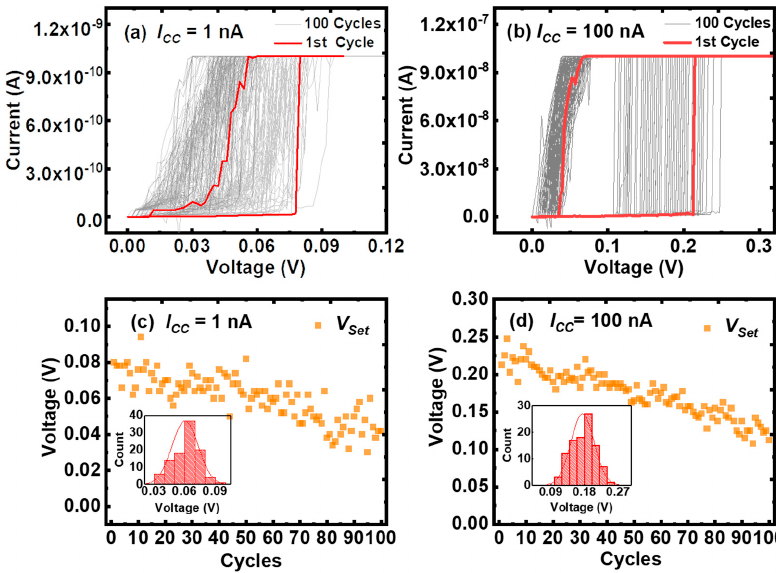
Figure 2. Typical threshold switching (TS) I-V curves under the compliance current limits of ( a ) 1 and ( b ) 100 nA. The statistics and distribution of Set voltages under the compliance current limits of ( c ) 1 nA, most of values are around 0.06 V, and ( d ) 100 nA, the values of Set voltages are observed around 0.18